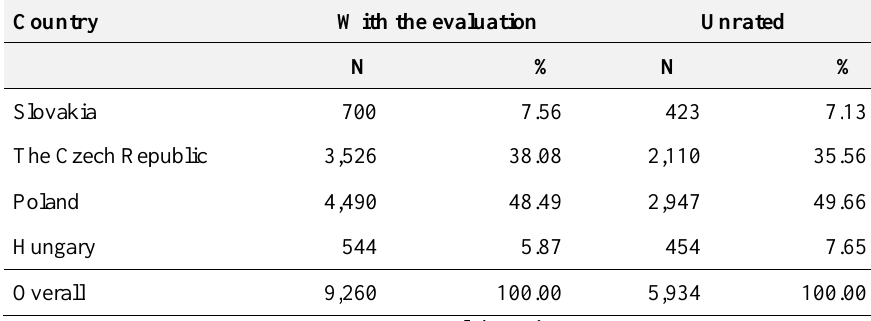
Table 1 – Number of e-shops with evaluation and without evaluation